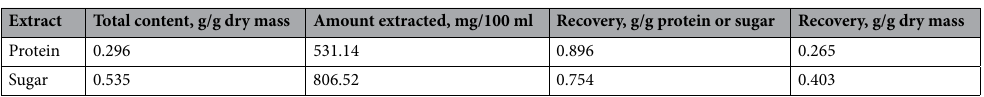
Table 4. Protein and sugar recovery from MAH of DSM-JP cocktail.